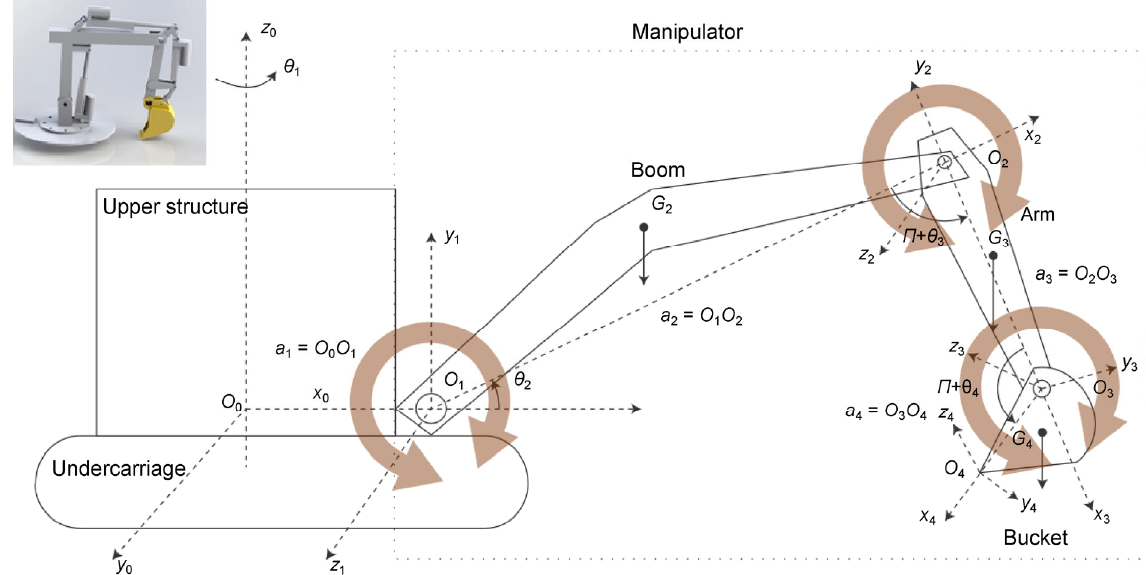
Fig. 4 The layout of a robot with a planar manipulator mechanism based on Ref. [55], the circle with arrows depicts the friction torques at rotary joints. The inset of the figure shows the rendering of a manipulator model generated within the computer aided design